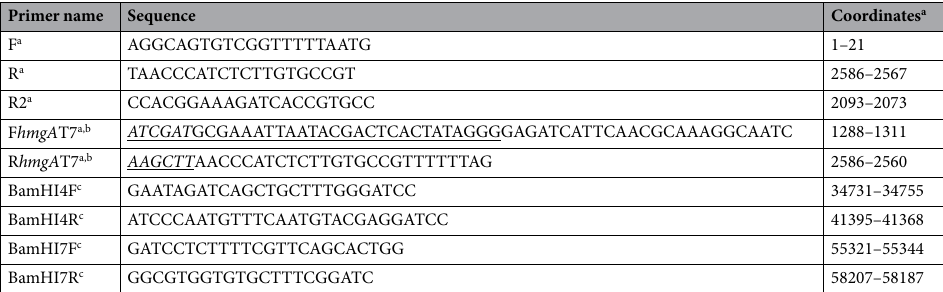
Table 2. Primers. a Coordinates according to the Vibrio anguillarum 775 chromosome I sequence, accession number CP002284, region: 1733068.1737000. b Double underlined sequence is the T7 promoter. Single underlined and italics underlined are the Cla I and Hin dIII restriction sites, respectively. c Coordinates according to the Vibrio anguillarum 775 pJM1 plasmid, accession number